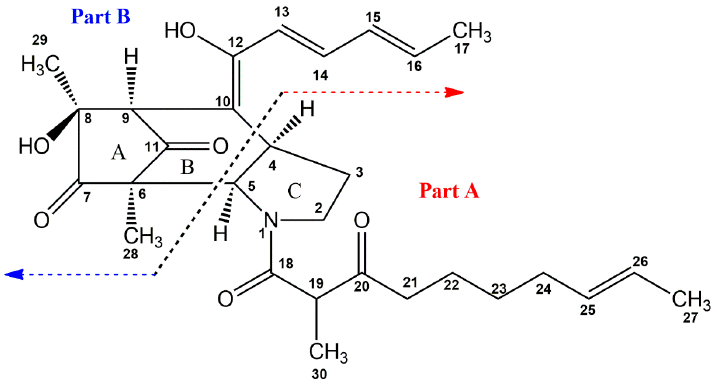
Figure 1. The structure of penicitroamide ( 1 ).